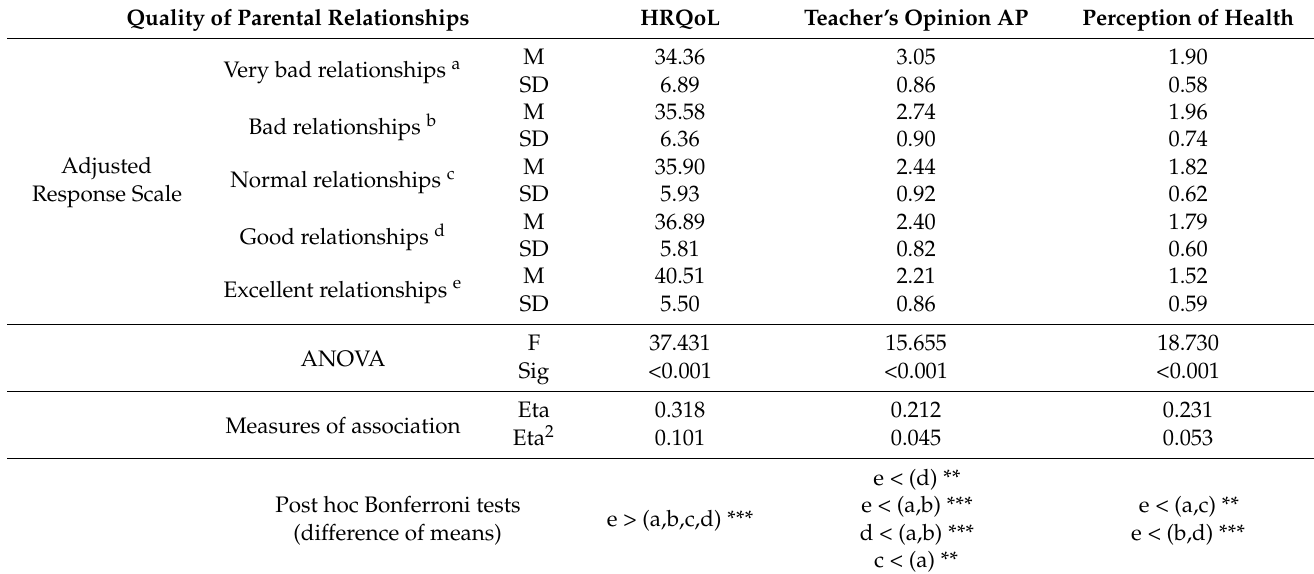
Table 2. Descriptive data and ANOVA analysis of HRQoL, teacher’s opinion and health perception according to parental relationships. Quality of Parental Relationships